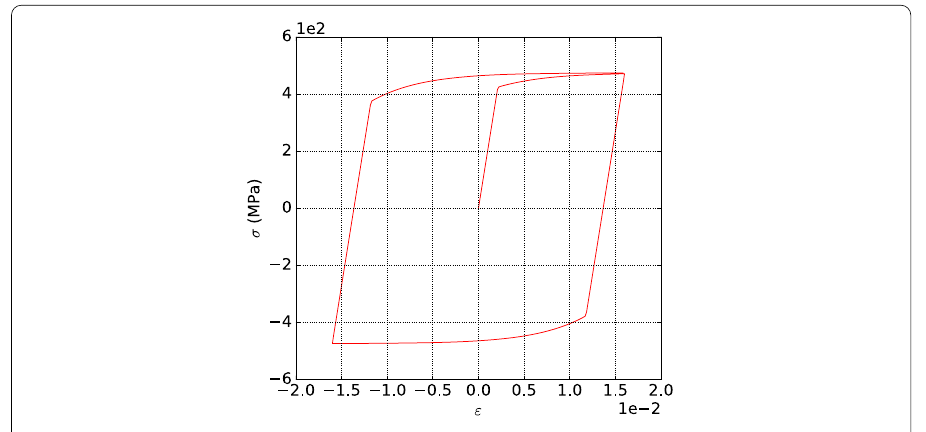
Fig. 22 Tensile/compression stress–strain curve at ˙ ε = 1s − 1